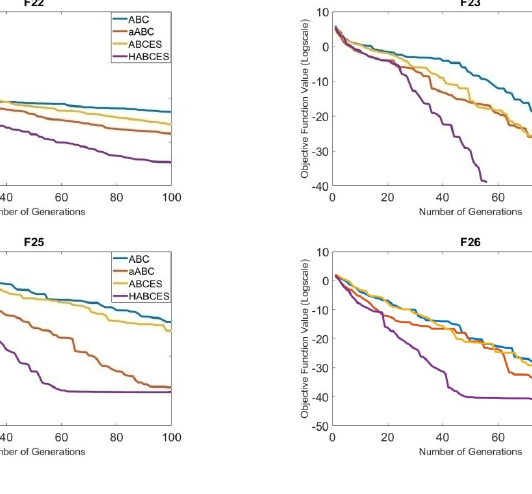
Figure 3. Comparison of the convergences of the ABC, aABC, ABCES and HABCES algorithms when solving low-dimensional global optimization problems (F21–F32).